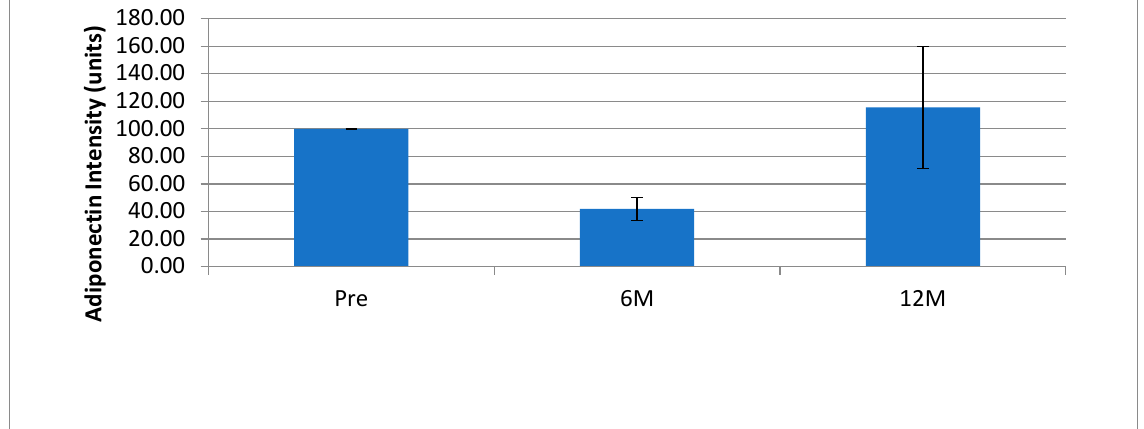
Figure 2. Salivary adiponectin levels showing standard error of bariatric patients before Roux-en-Y (PS) gastric bypass surgery, 6 months (6 m) and 12 months (12 m) after surgery ( n = 9, sample 37 excluded).